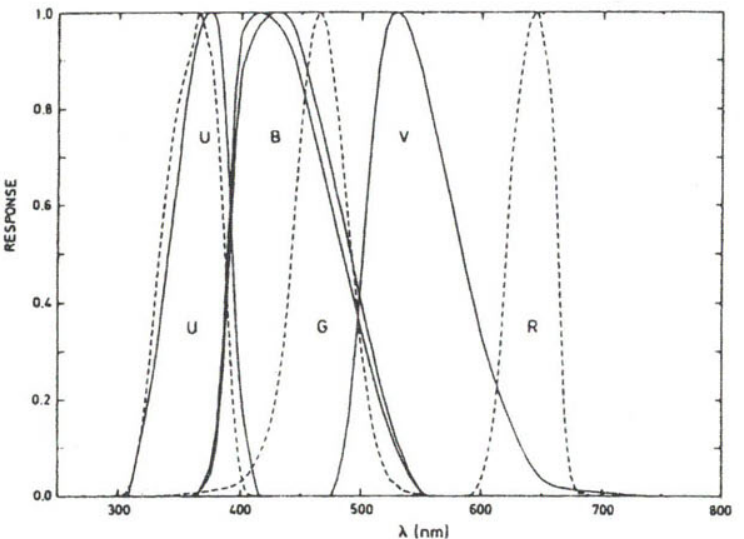
Fig. 2. The normalized response functions of the photographic RGU (dashed lines) and the photoelectric UBV (solid lines) standard systems (Buser